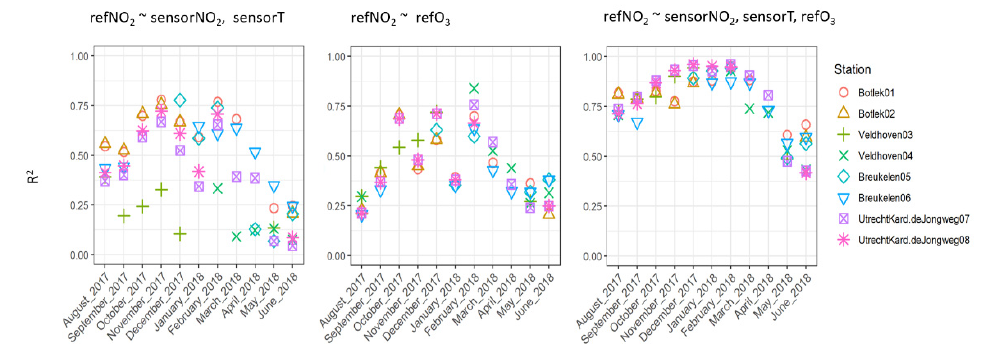
Figure 9. R 2 for calibration based on three different regressions. All available data in the months prior to the validation month have been used to derive the